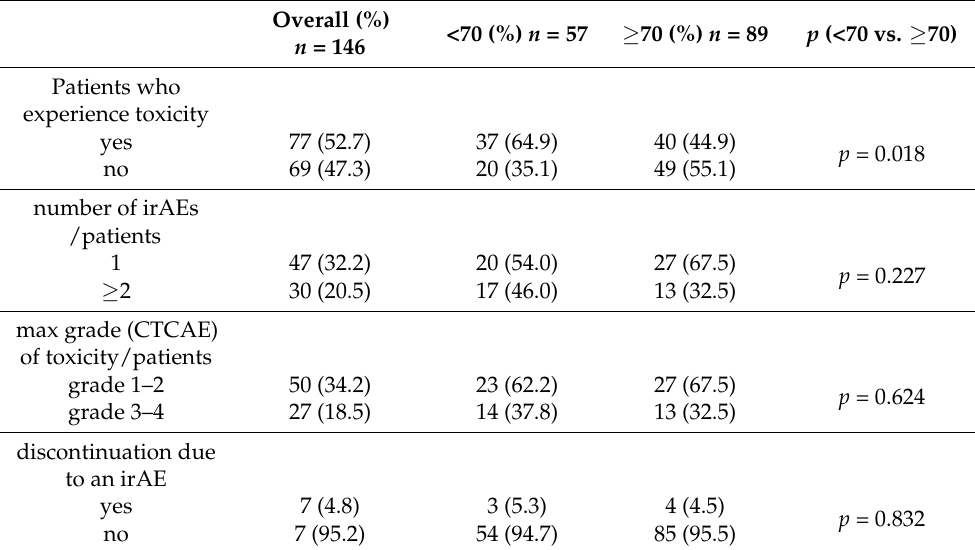
Table 2. irAE patient description. Events and grading were split into age groups (<70 and ≥ 70).